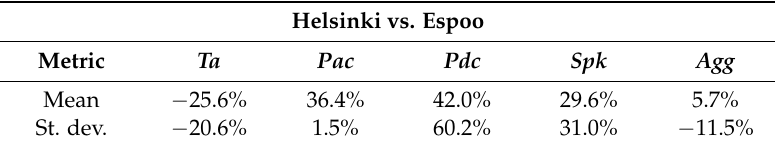
Table 3. The relative difference between operation factors on Helsinki and Espoo trips.